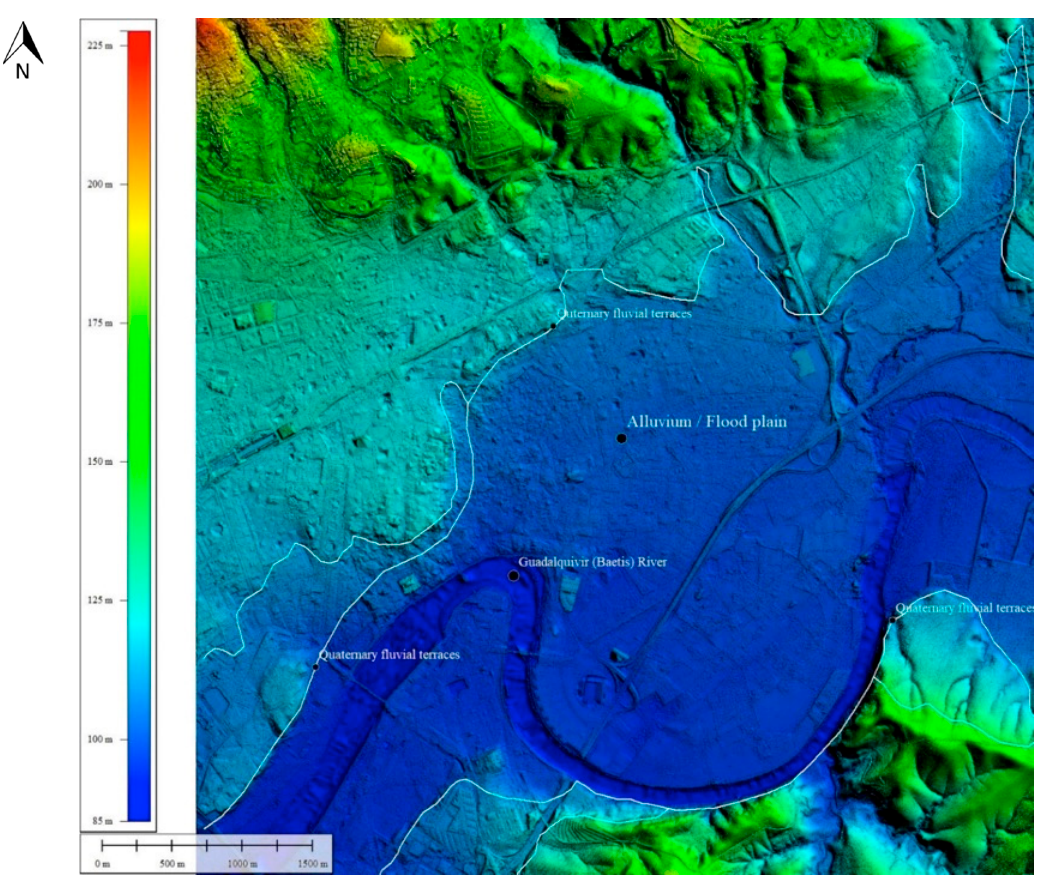
Figure 3. Territorial landscape of Cordoba. Mountains (North: Sierra Morena), quaternary fluvial terraces and alluvium of the Guadalquivir River. DSM processed from LAS files. The © PNOA-LiDAR 2016 CC-BY 4.0 ign.es files were processed with the Global Mapper 18.1 colour ramp shader hillshade by Antonio Monterroso-Checa. Coordinates in the central axis of the image: 37°52´43´´, 4°45´00”.